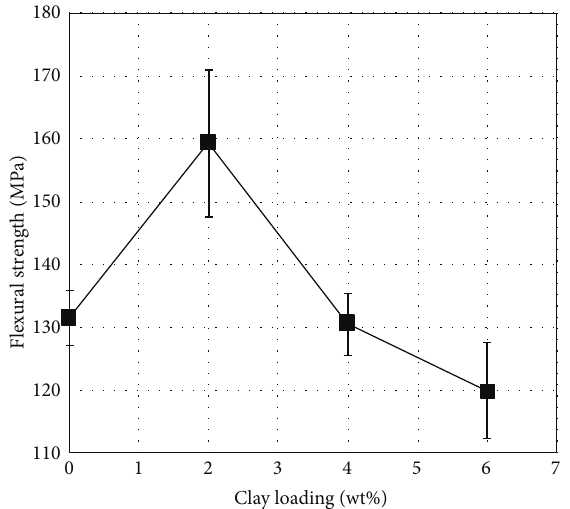
Figure 3: Effect of clay loading on the tensile strength of UP/glass fiber/clay composites.